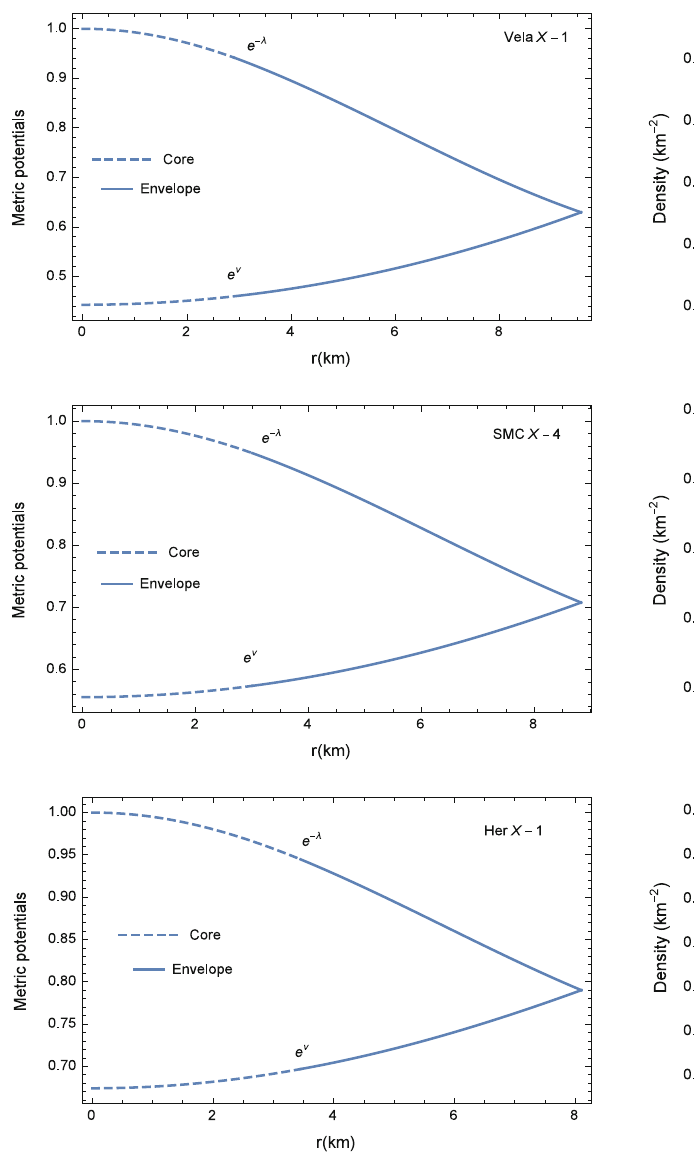
Fig. 2 Variation of density with radial coordinate r for (i) the neutron star in Vela X-1(upper) (ii) SMC X-4 (middle) (iii) Her X-1 (lower) and the constants C 1 , C 2 , β are of the